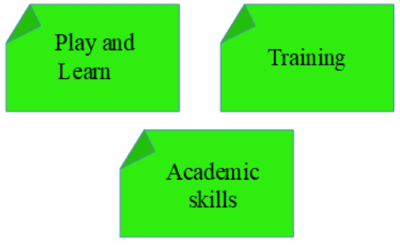
Figure 15. Consensual Game Script.